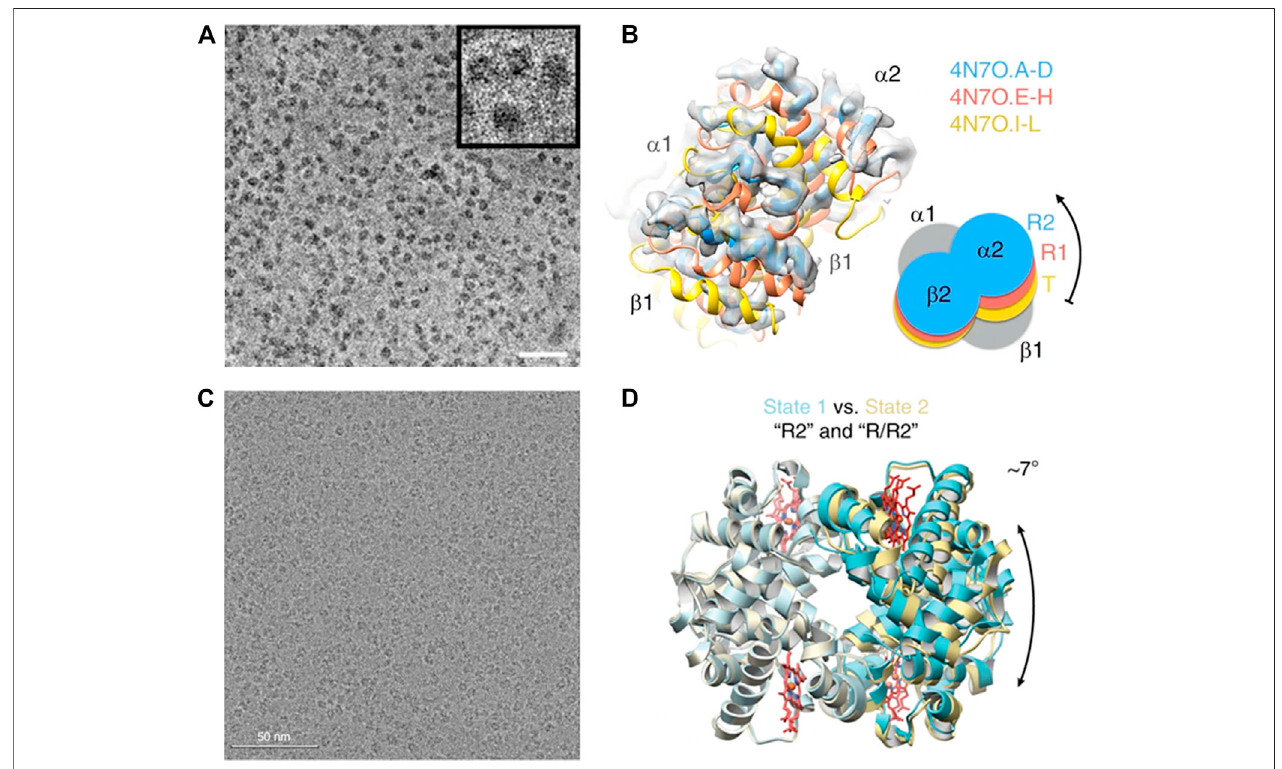
FIGURE 3 | Single particle cryo-EM reveals co-exiting conformations of haemoglobin. (A) Visualization of haemoglobin with the aid of Volta phase plate (see the milestonesin Figure 2B ). (This fi gure is adopted from Figure 1A ofRef 41, an open access article distributed under the terms of the Creative Commons CC BY license. https://creativecommons.org/) (B) Modeling the cryo-EM map with known X-ray structures suggests the co-existing conformations. (This fi gure is adopted from Figure 1E ofRef 41,an open access article distributed under the terms oftheCreativeCommons CC BY license. https://creativecommons.org/). (C) Visualization ofhaemoglobininthinicewithoutphaseplate.This fi gureisadoptedfrom Figure1A ofRef42. (D) Resolvingthecryo-EMmapwiththeusageofK-way3Dclassi fi cation on RELION indicates the co-existing conformations. (This fi gure is adopted from Figure 1E of Ref 42, an open access article distributed under the terms of the Creative Commons CC BY license.